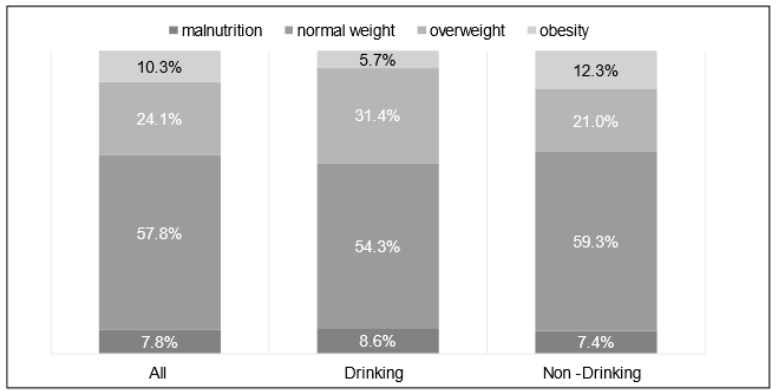
Figure 2. Prevalence of malnutrition, normal weight, overweight, and obesity categories. Table 2. Comparison of biochemical data on alcoholic cirrhosis between the drinking and nondrink- ing groups.